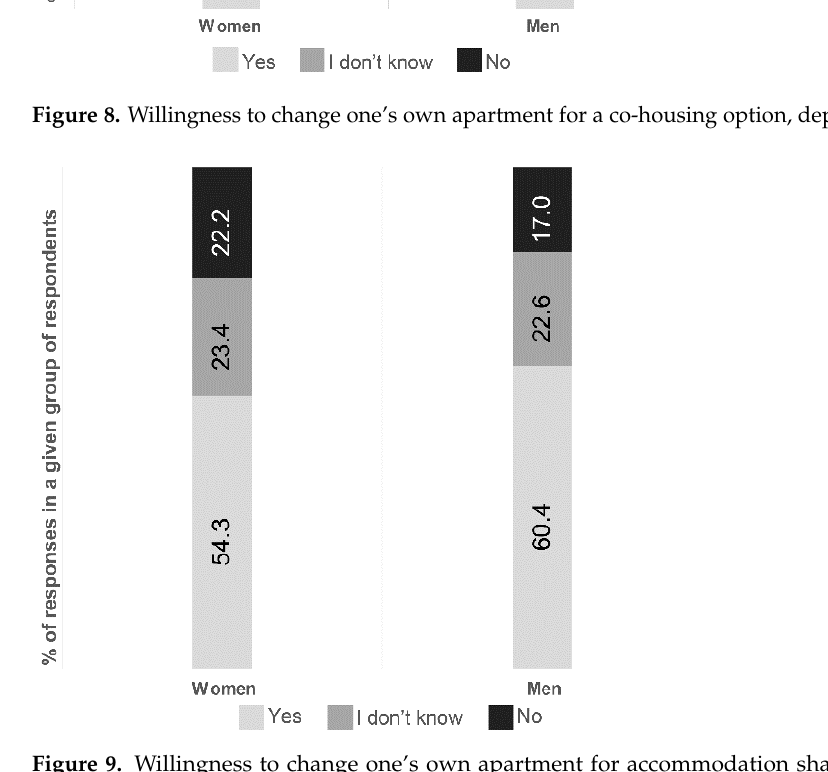
Figure 9. Willingness to change one’s own apartment for accommodation shared with children, depending on gender.